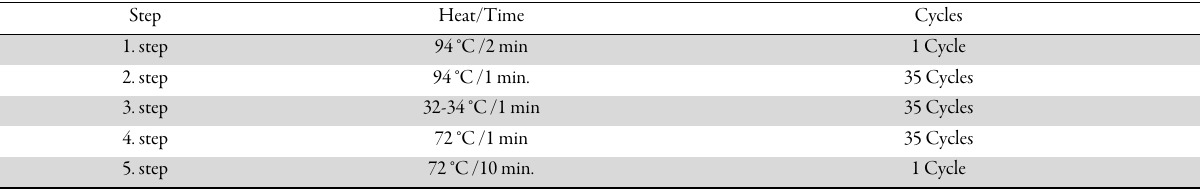
Table 2. Cycles program for RAPD-PCR